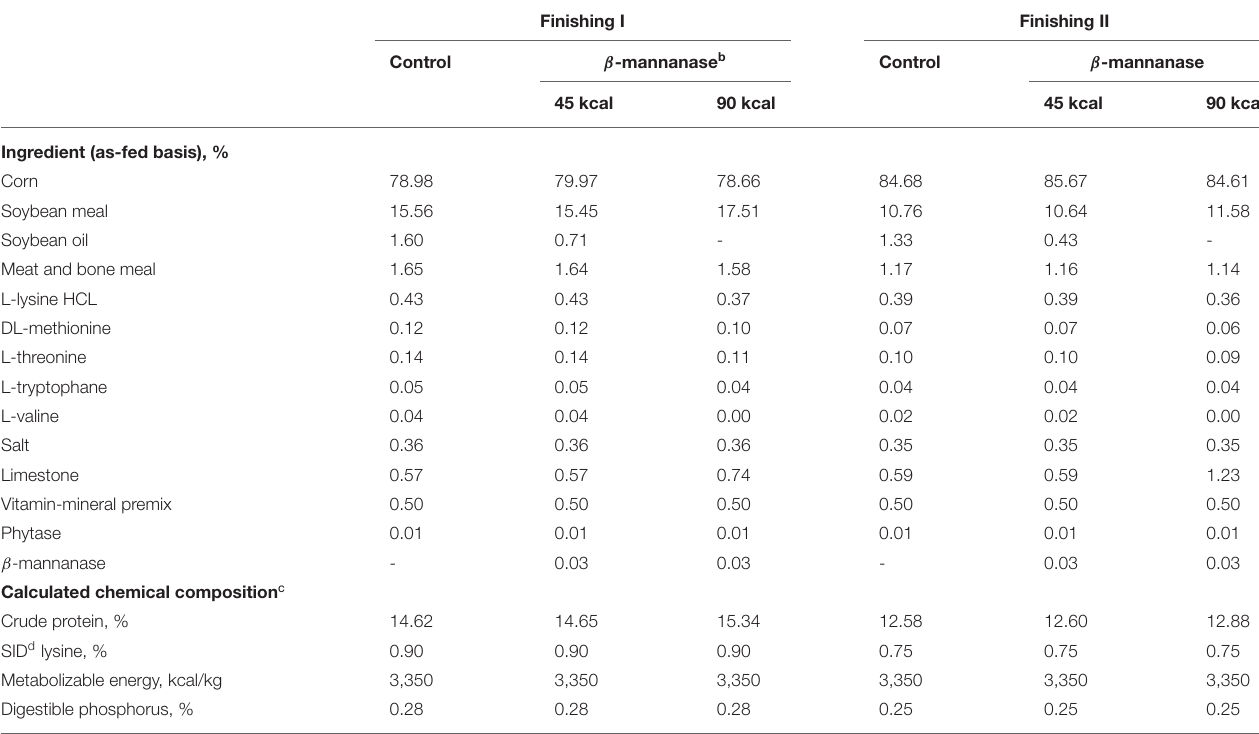
TABLE 3 | Composition of finishing pig feeds a